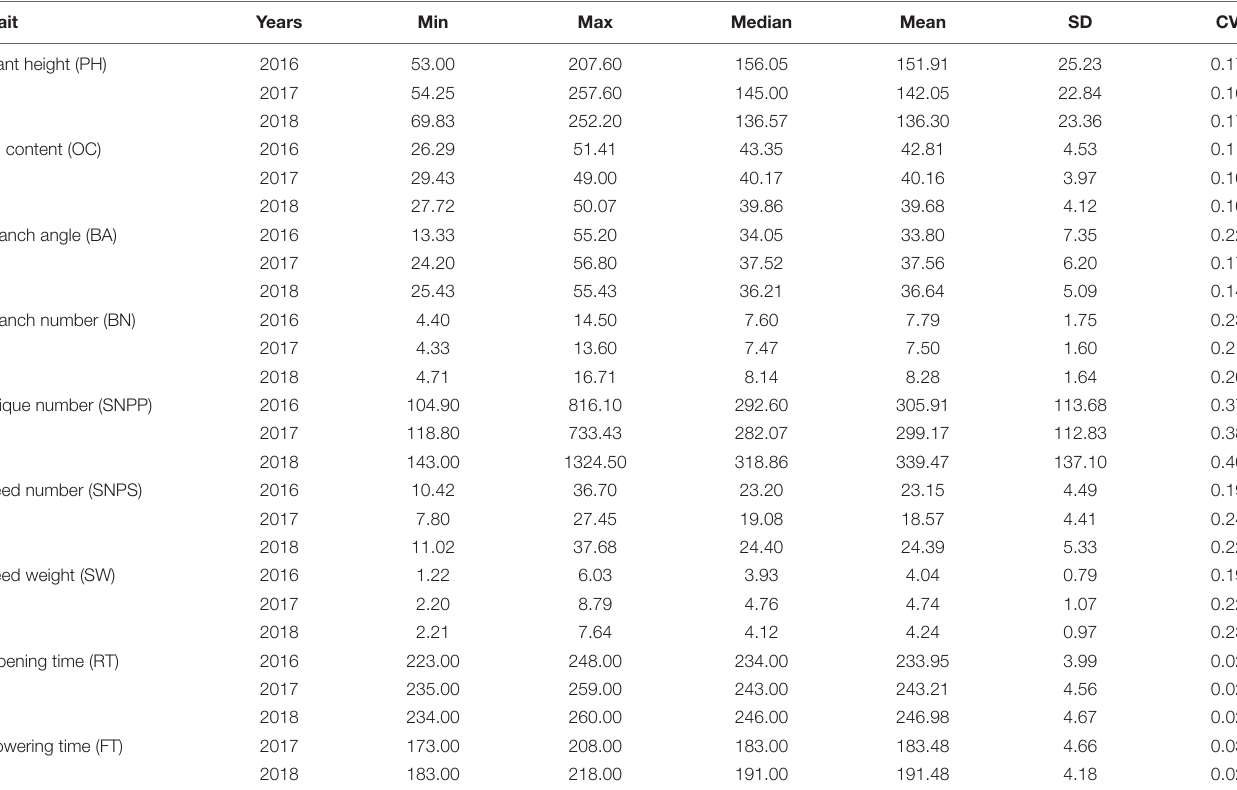
TABLE 1 | Phenotypic variations analysis among 210 B. napus accessions in the correlation panel.